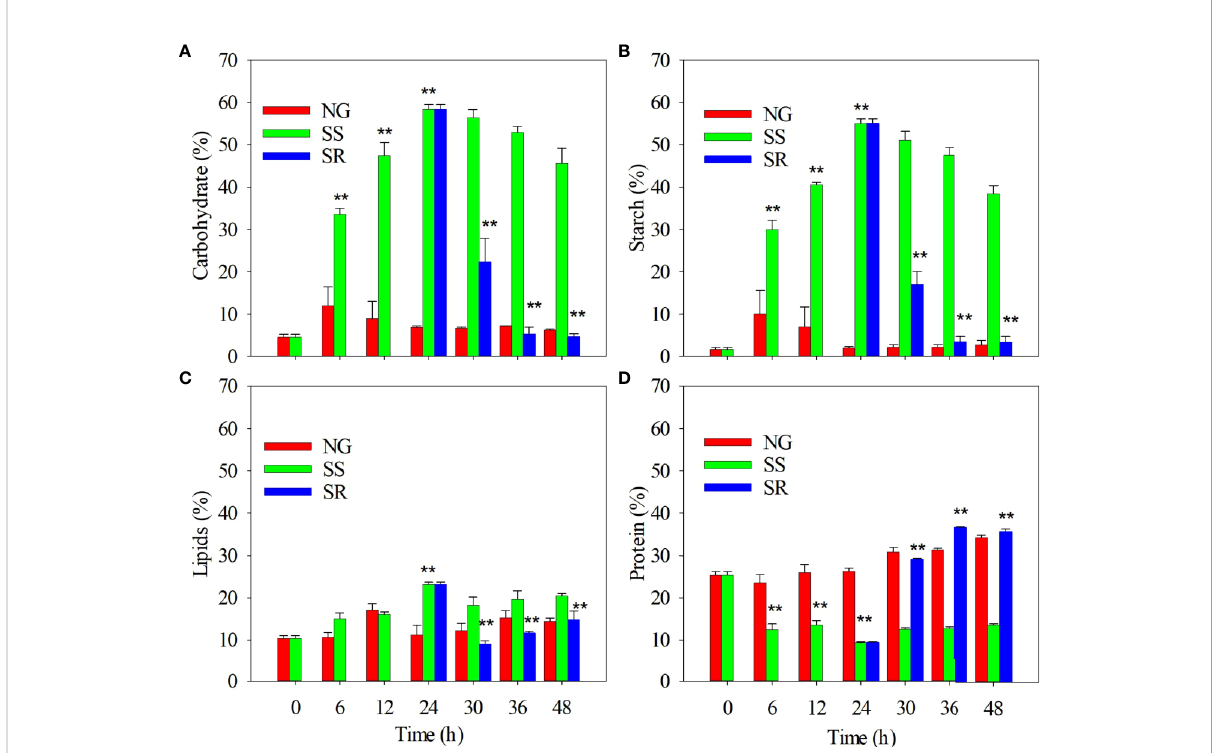
FIGURE 2 Effect of sulfur nutritional status on accumulation of carbohydrates (A) , starch (B) , lipids (C) , and proteins (D) in C. sorokiniana cells. NG, normal growth; SS, sulfur starvation; SR, replenishment. The ** indicate the signi fi cant differences of samples under SS compared to NG conditions from 6 h to 24 h, and the signi fi cant differences of samples under SR compared to SS conditions from 30 h to 48